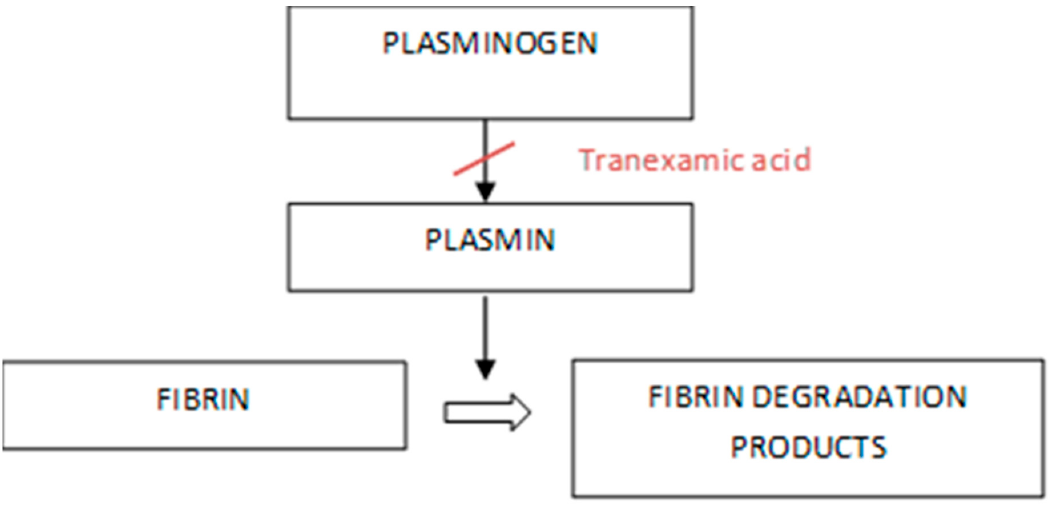
Figure 4. Tranexamic acid working [1].